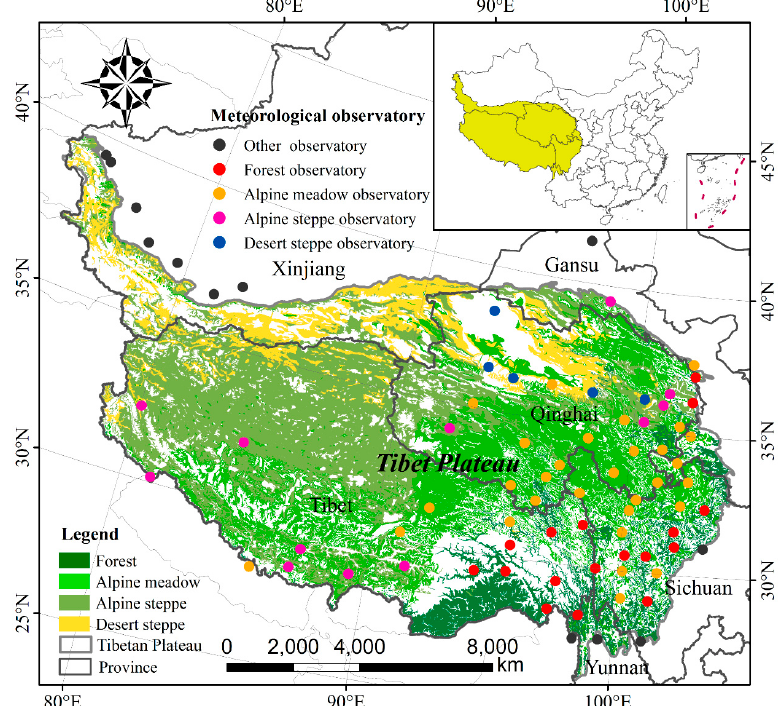
Figure 1. The study area and location of the meteorological stations. The ecosystems covered forest, alpine meadow, alpine steppe, and desert steppe.